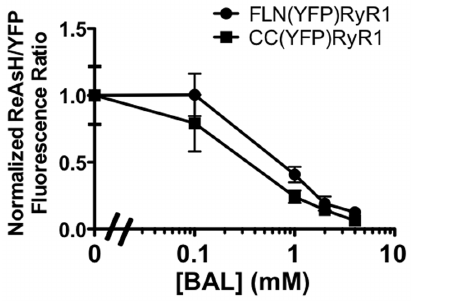
Figure 4. ReAsH binding stability to two different Tc tags on RyR1. HEK-293T cells expressing FLN(YFP)RyR1 or CC(YFP)RyR1 labeled with ReAsH were incubated in increasing [BAL] for 15 9 followed by quantification of YFP and ReAsH fluorescence. Values represent mean ReAsH/YFP fluorescence ratio normalized to this ratio acquired at 0 BAL for 9–12 cells per datum point.